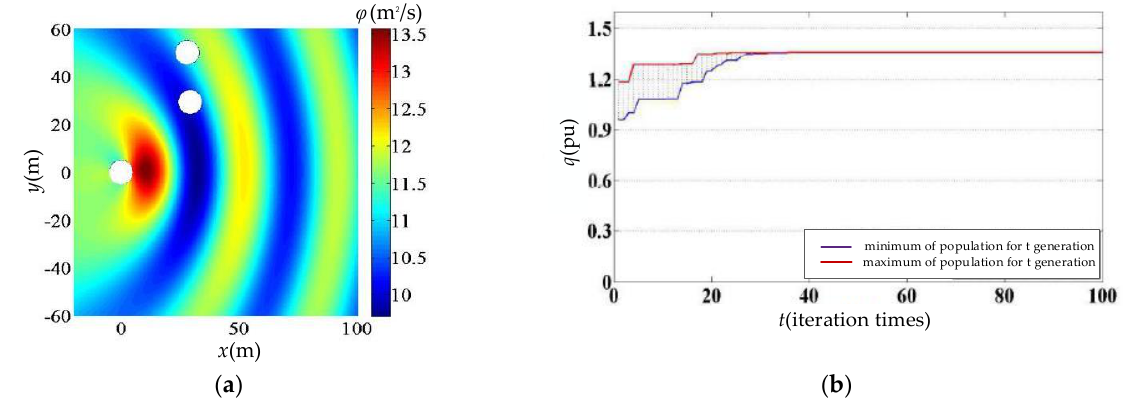
Figure 8. Optimal results for the three-float array: ( a ) the optimal position; ( b ) individual fitness values for each generation.